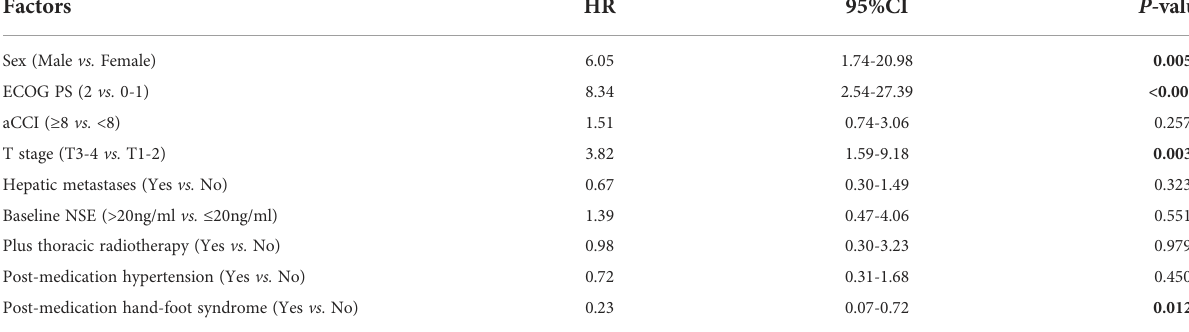
TABLE 3 Multivariate Cox regression analysis of factors associated with PFS.